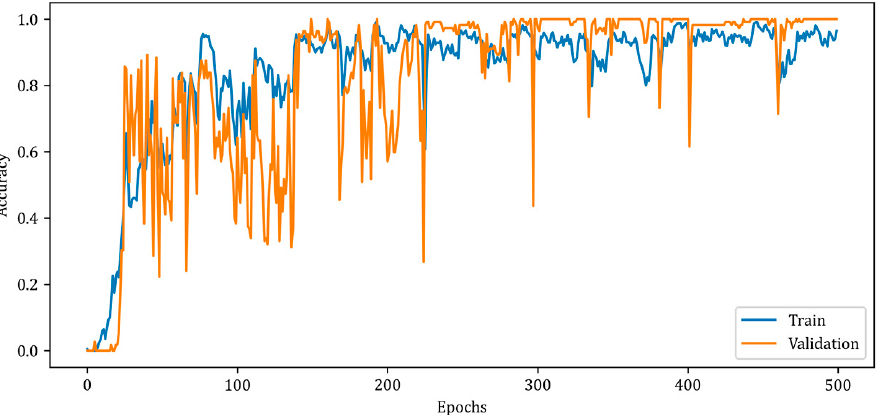
Figure 10. Accuracy curves for training and validation phases of the proposed CV-MWINet model.